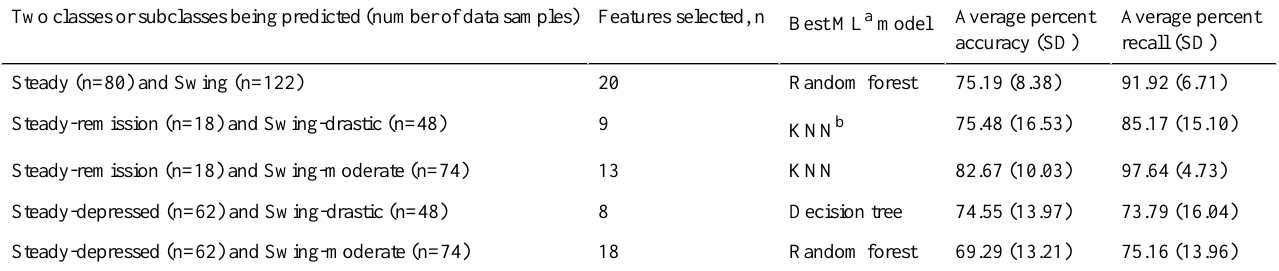
Table 6. Classification result using selected features of heart rate data.